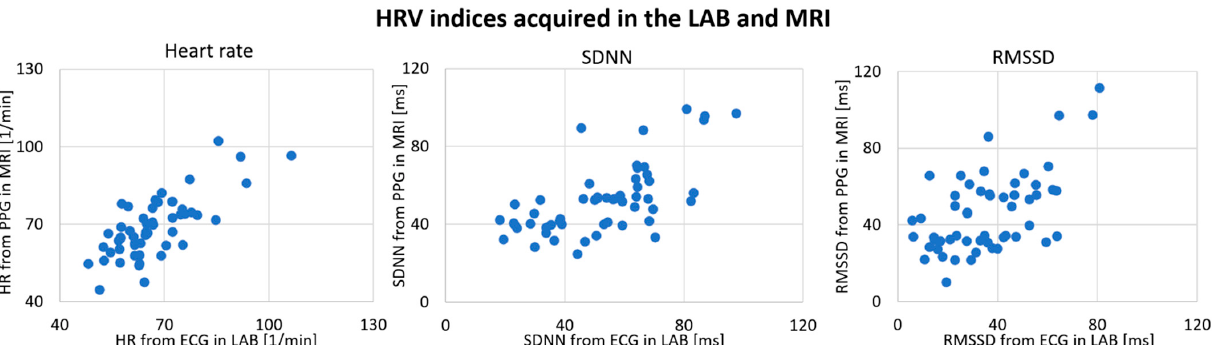
Figure 3. Comparison of HRV from photoplethysmogram recordings during MRI sessions compared with electrocardiogram recordings from the laboratory (N = 55). HR: mean heart rate; SDNN: standard deviation of heart beat intervals; RMSSD: root mean square of successive heart beat intervals; ECG: HRV derived from an electrocardiogram recorded in the laboratory; PPG: HRV derived from a photoplethysmogram recorded during MRI.